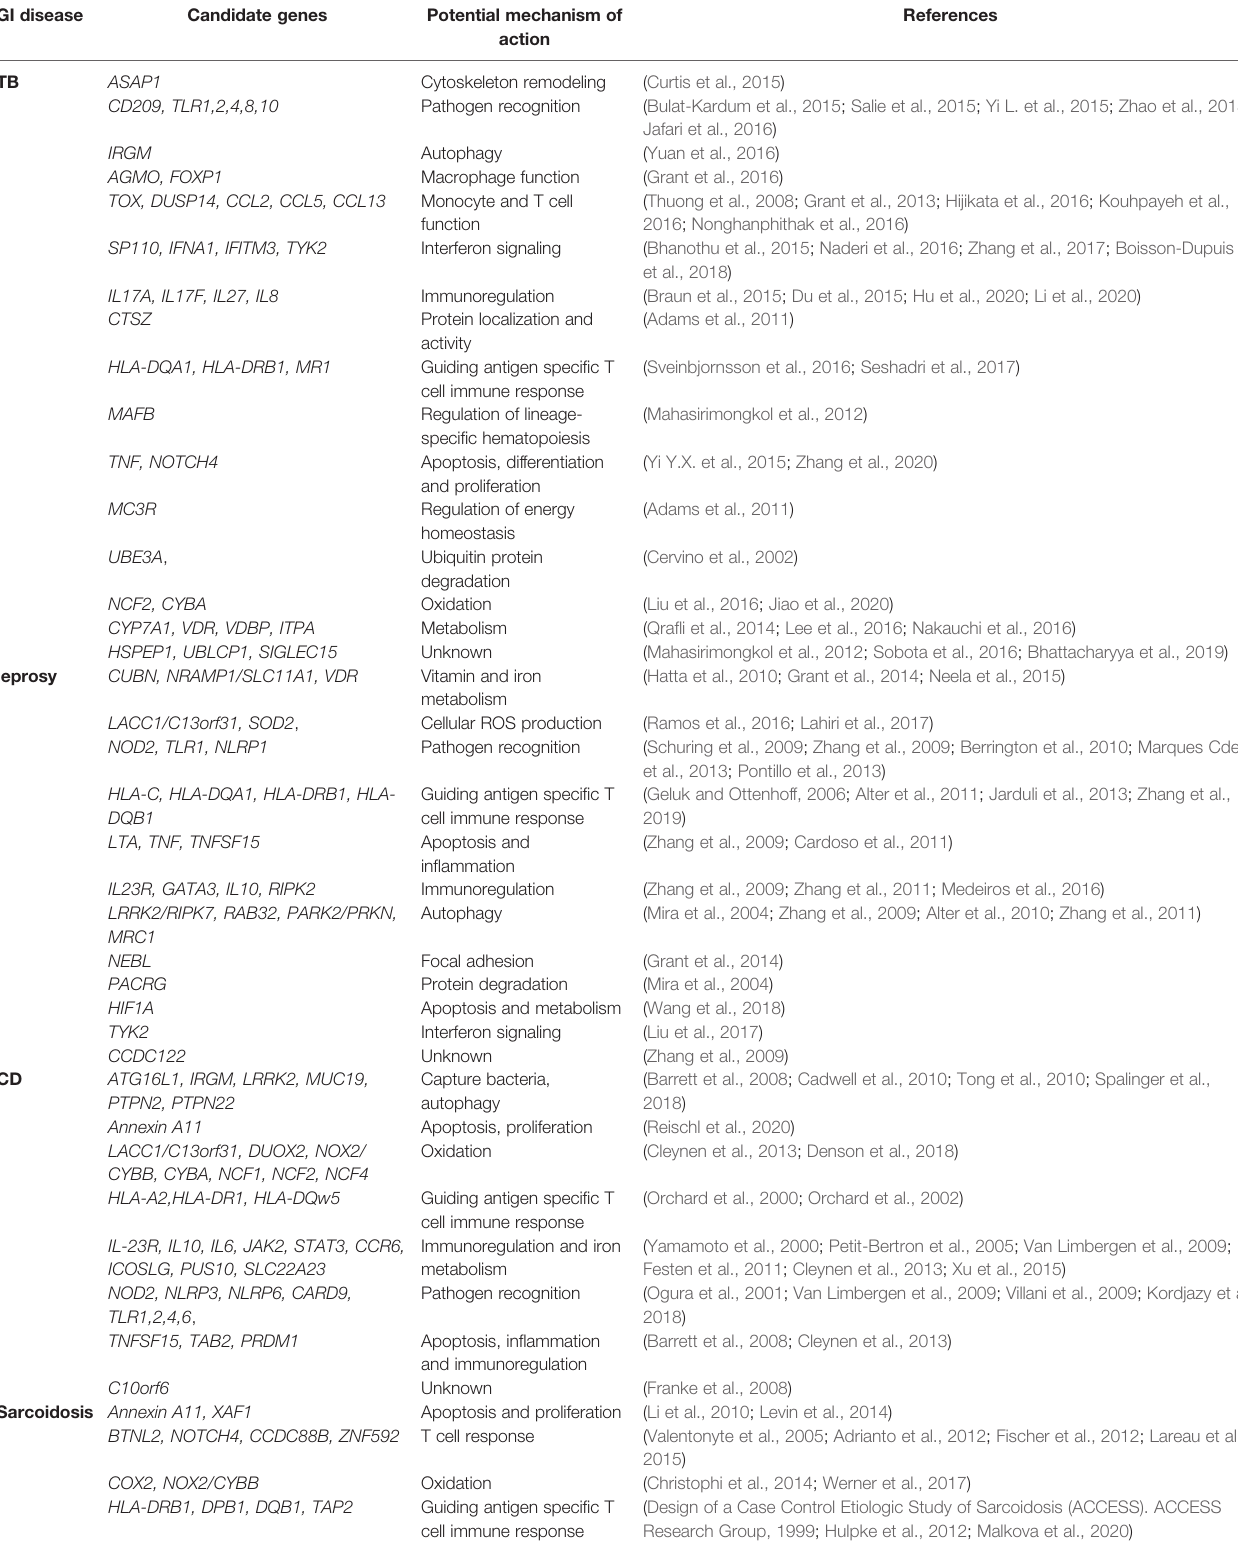
TABLE 2 | Summary of candidate genes linked to GI diseases. GI